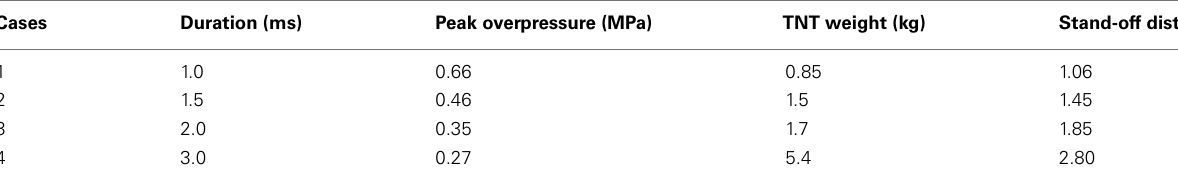
Table 3 | Stand-off distances and explosives required to achieve the overpressure for four blast loading cases.